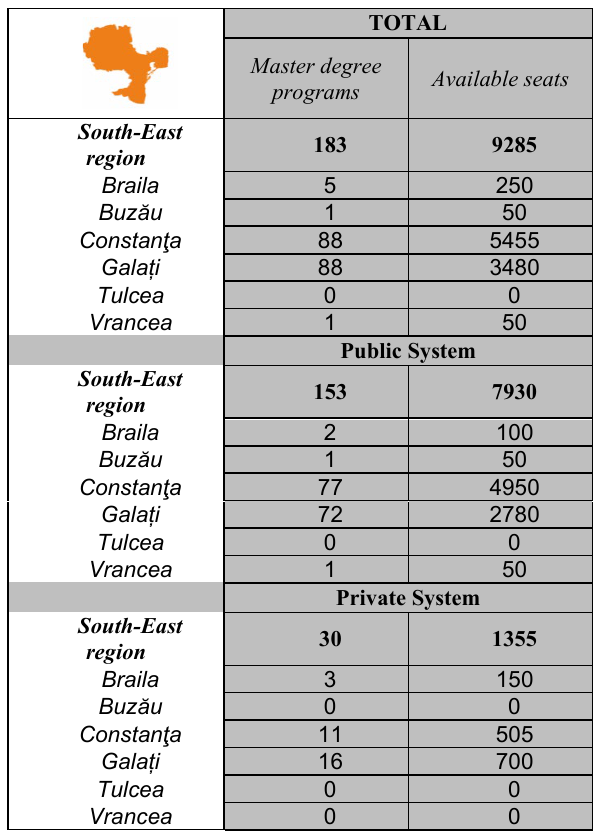
Table 1. Regional distribution of master programs